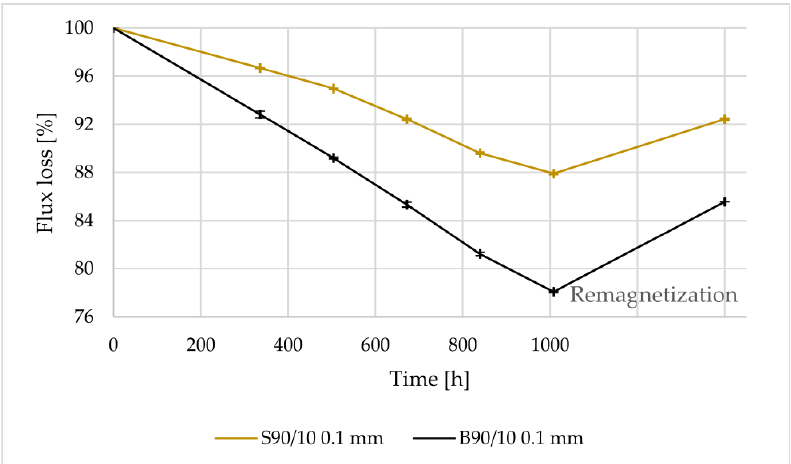
Figure 11. Flux loss of FDM-printed samples S90/10 and B90/10 vs. time exposure to corrosive water at 95°C for 1000 h and after final remagnetization.